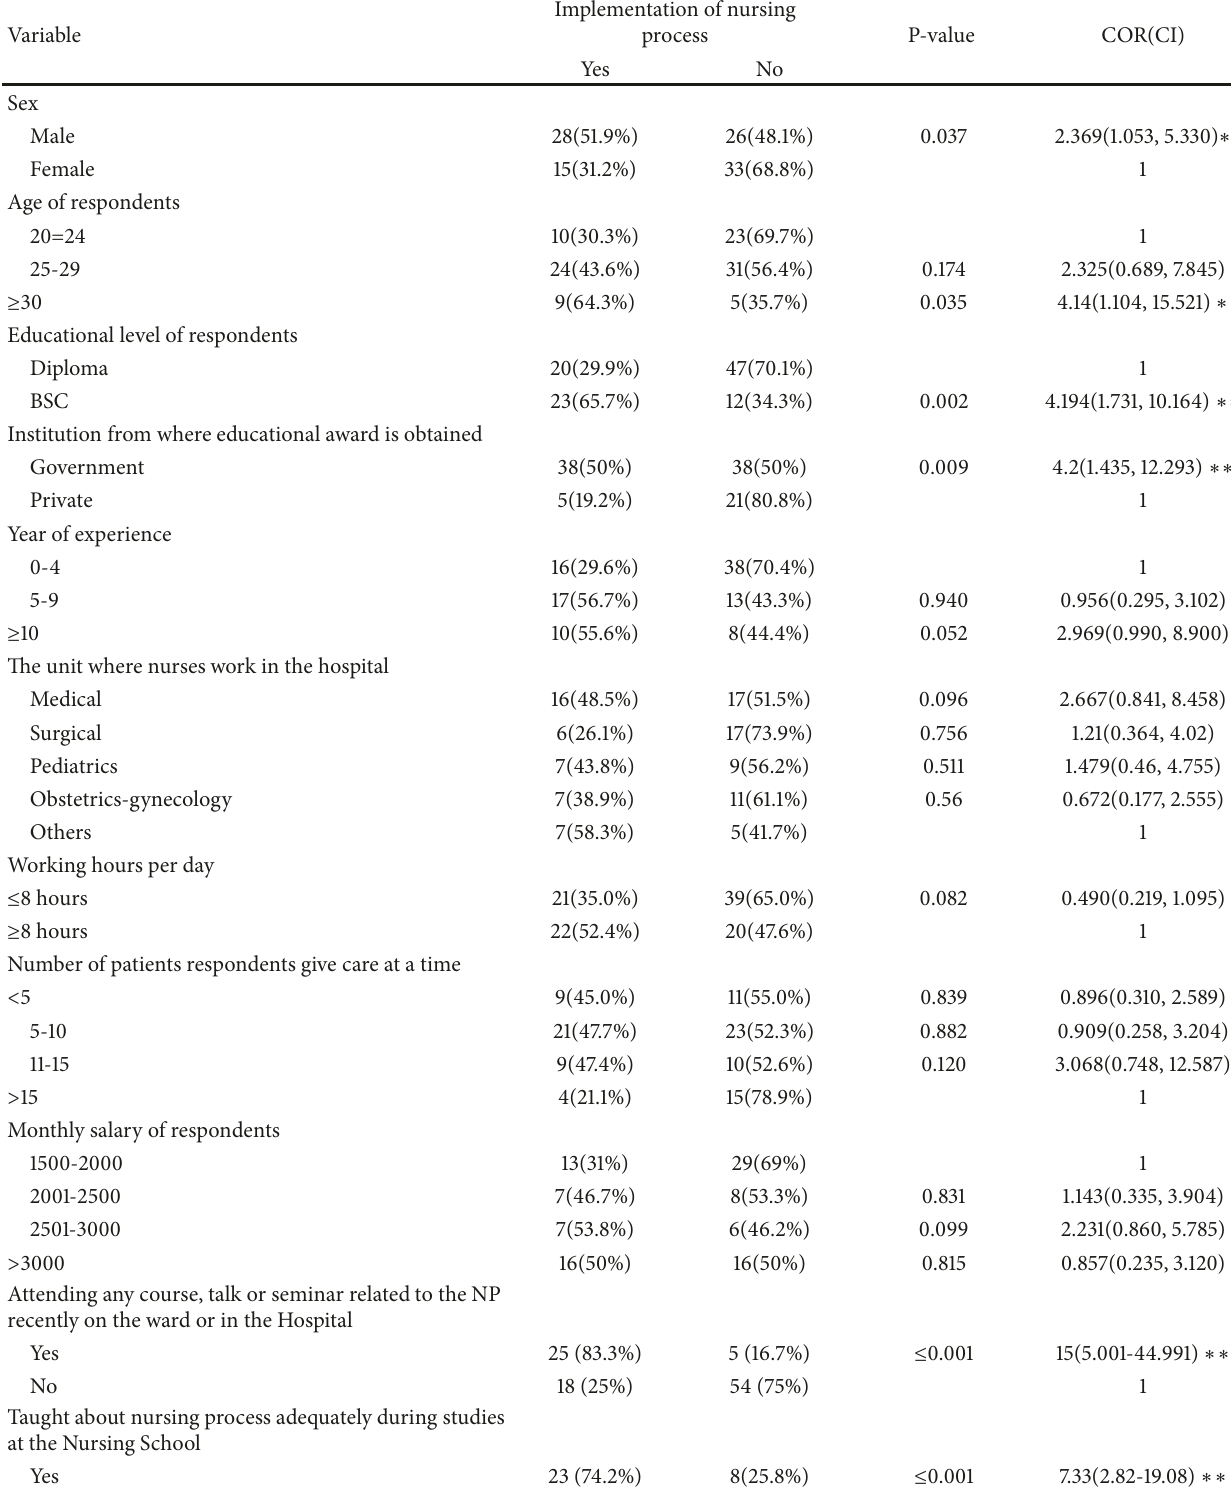
Table 3: Binary logistic analysis and association of implementation of nursing process by selected variable among nurses in Afar region Hospitals, north East Ethiopia, 2016 (n=